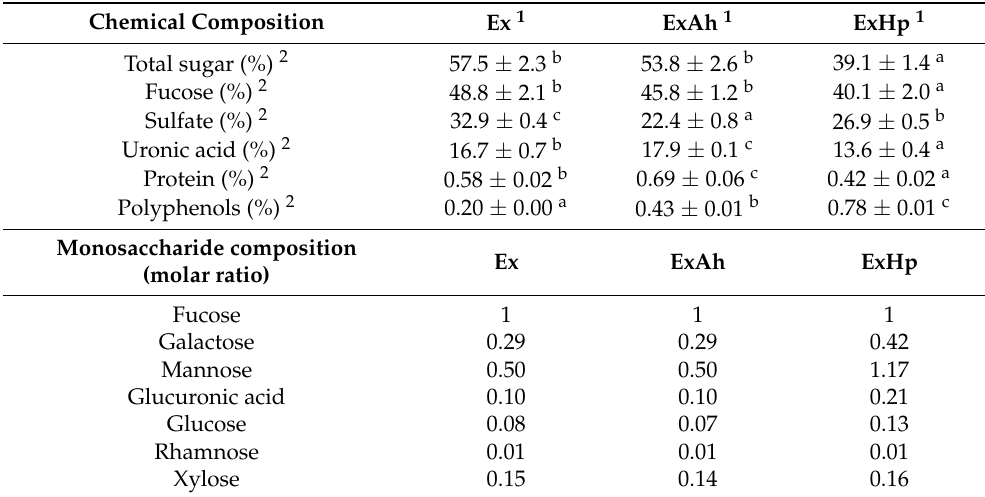
Table 4. Composition analyses for Ex, ExAh, and